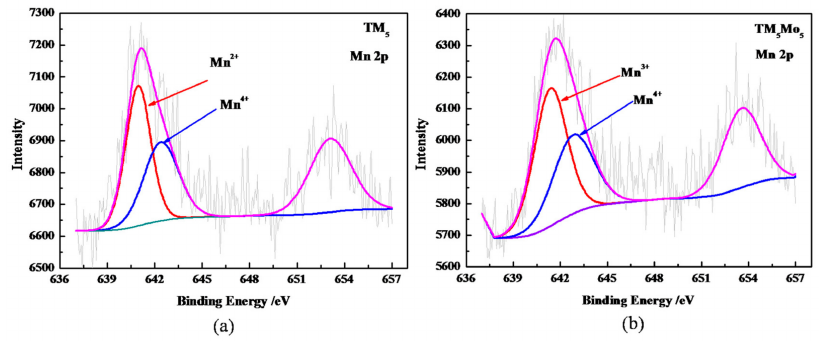
Figure 4. The XPS analysis of Mn 2p for ( a ) TM 5 ; and ( b ) TM 5 Mo 5 .